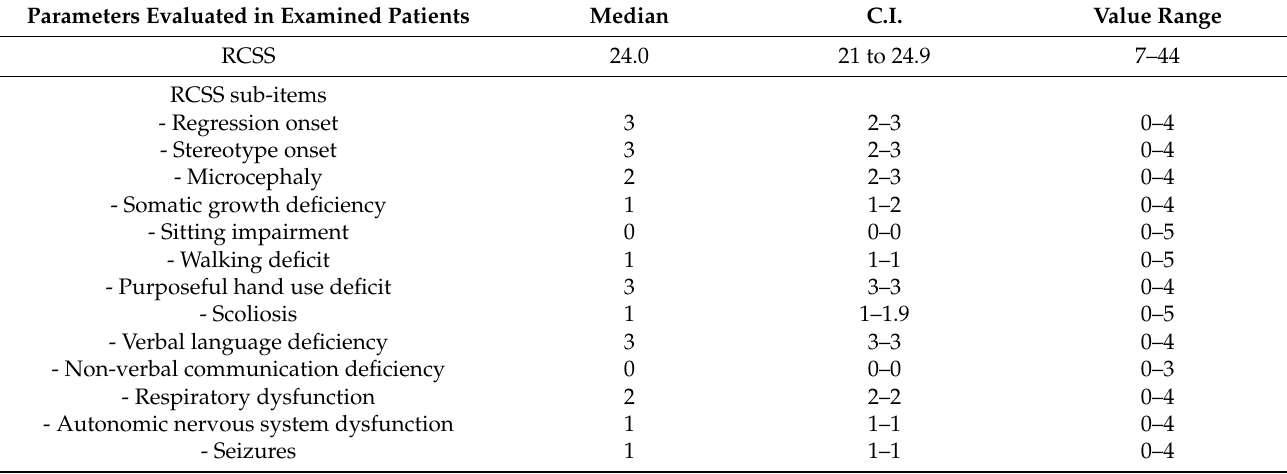
Table 4. Rett Clinical Severity Scale (RCSS) in RTT examined population.